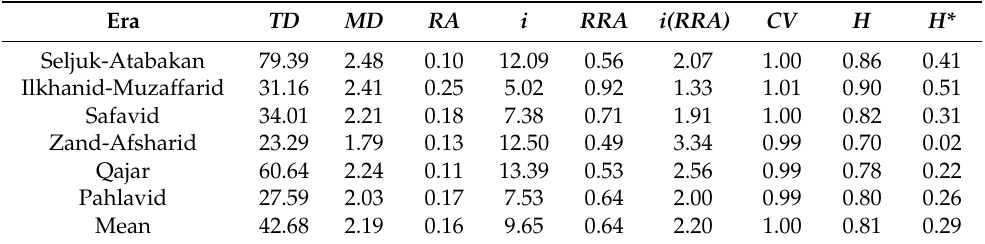
Table 5. Mean results for six eras. Note that the Seljuk-Atabakan and Zand-Afsharid eras each have only one